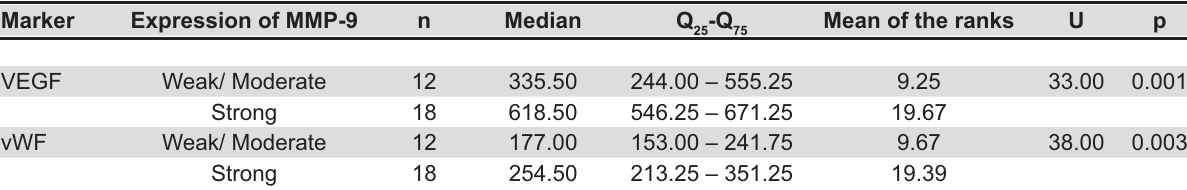
Table 4- Parameters used for the calculation of the Mann-Whitney U test for the evaluation of the expression of vascular endothelial growth factor (VEGF) and von Willebrand factor (vWF) according to the expression of matrix metalloproteinase-9